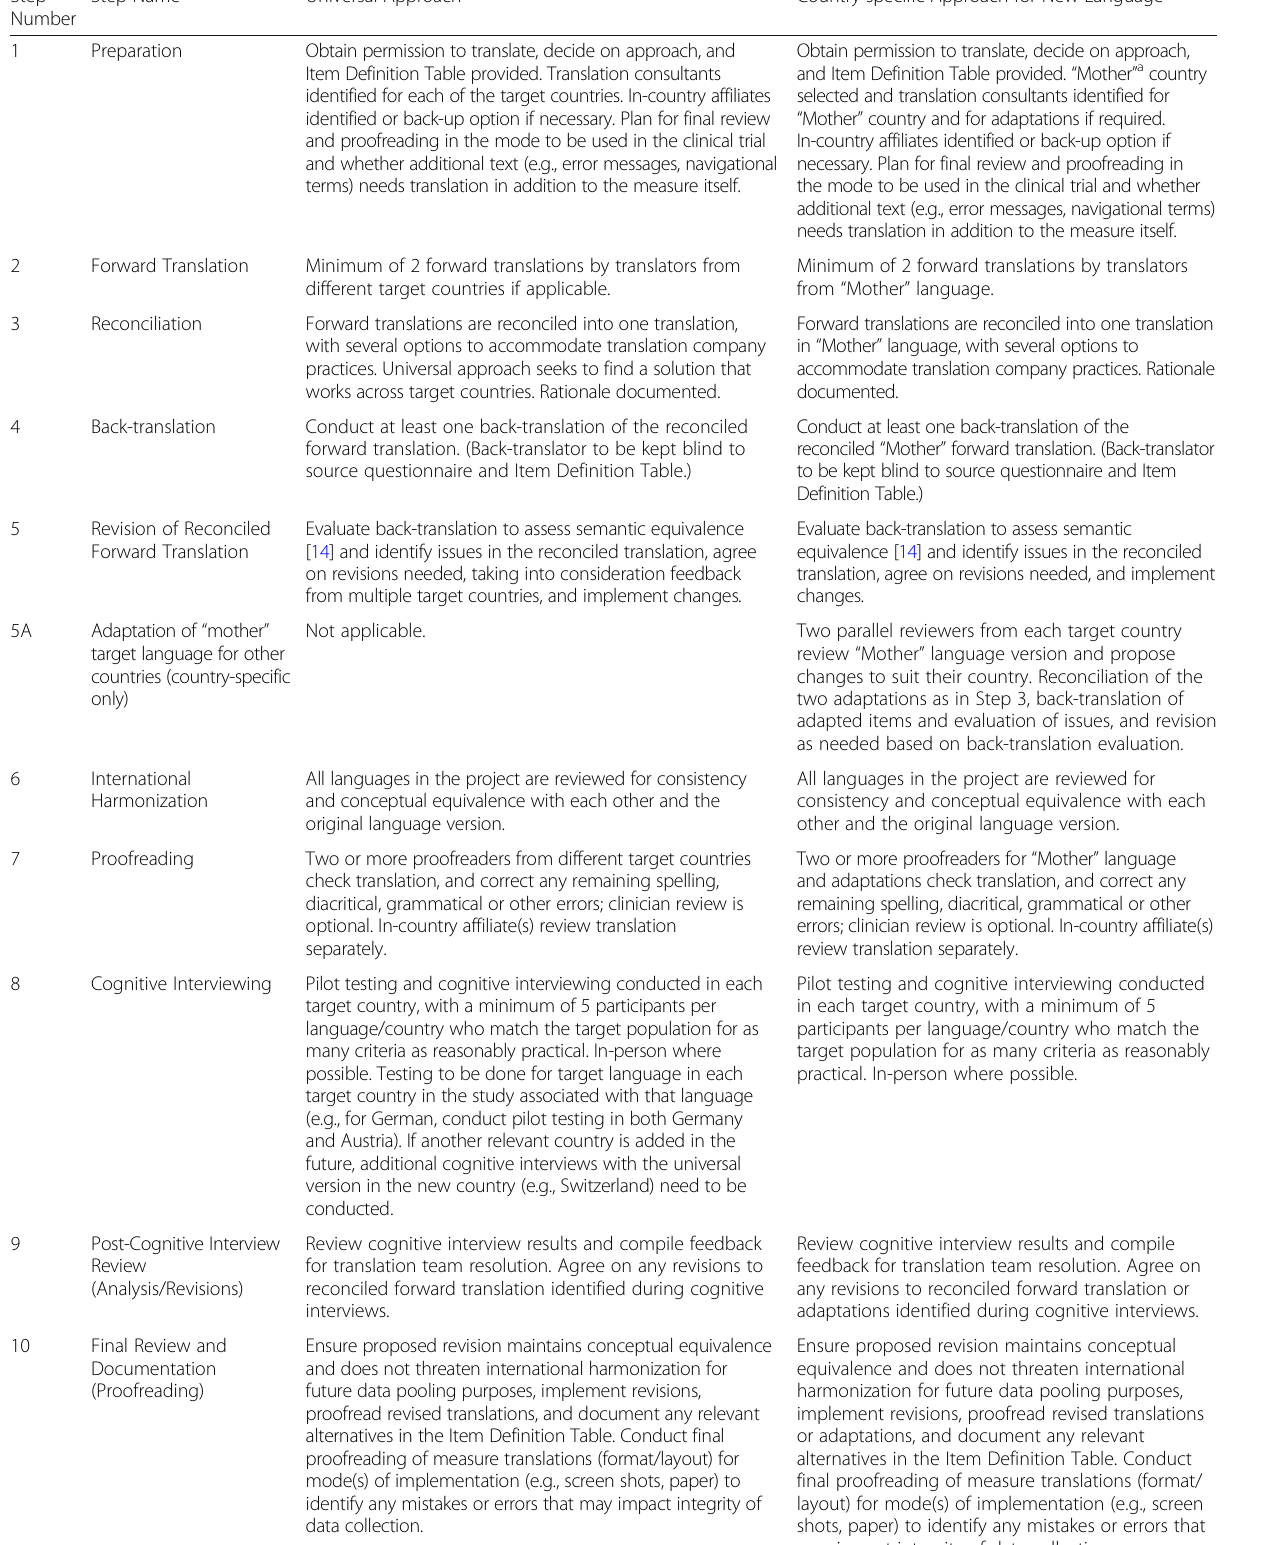
Table 3 PRO Consortium Translation Process